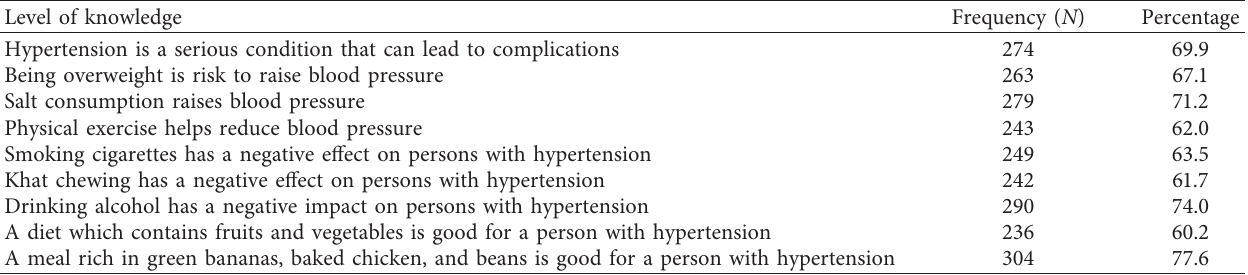
Table 4: Level of knowledge on hypertension self-care of hypertensive patients on Debre Tabor Referral Hospital, Northwest Ethiopia, 2020.